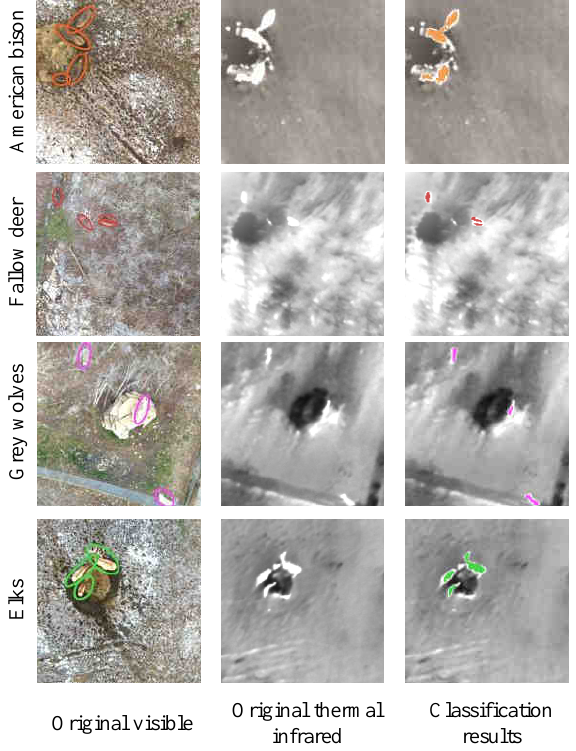
Figure 5. Examples of the classification results for the MOBIA with the visible and thermal infrared imagery. Orange . American bison ( Bison bison ); Red . fallow deer ( Dama dama ); Magenta . grey wolves ( Canis lupus ); and Green . elks ( Cervus canadensis ).